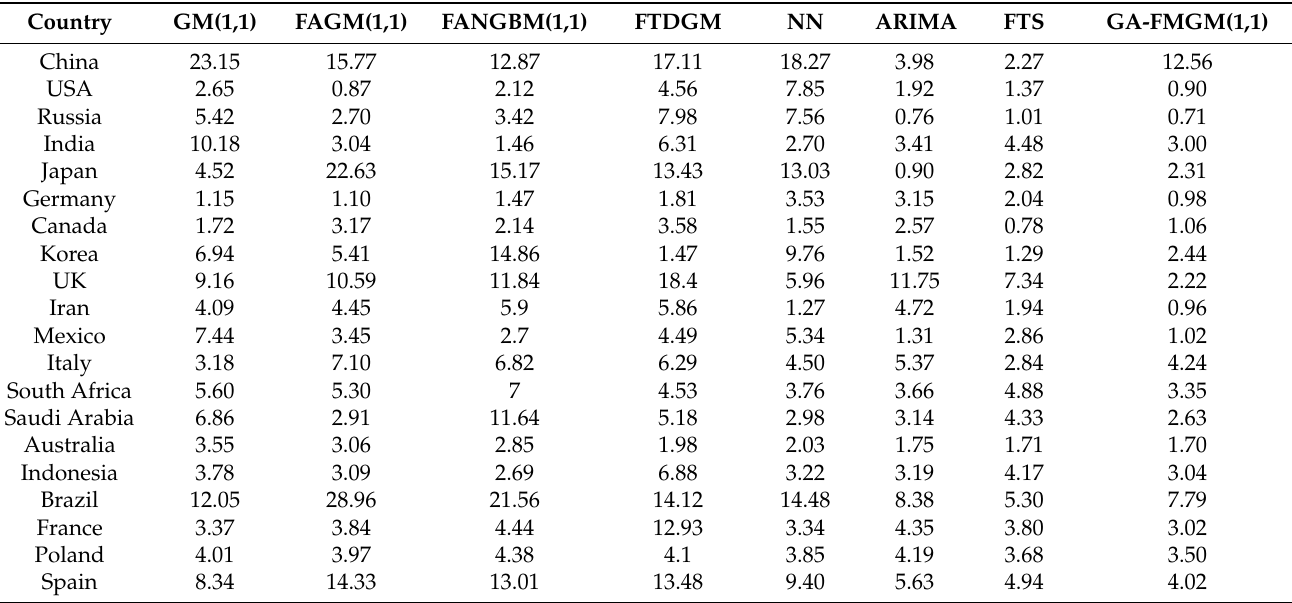
Table 2. MAPE of different prediction